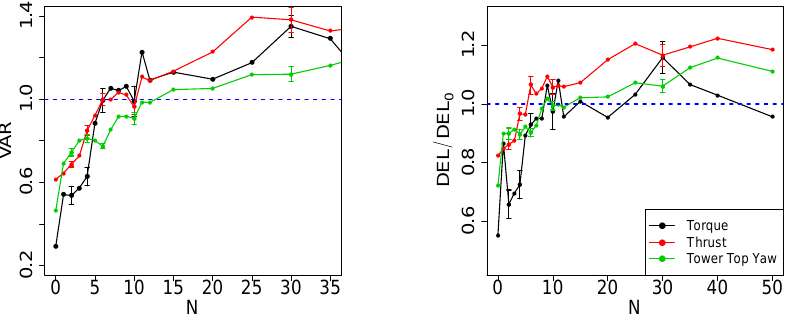
Figure 25. Variance and DELs for different loads versus no. of modes included in the spectral model with added turbulence. Standard errors are shown for the spectral model for N = 2,4,6,10,30. They are estimated from the standard deviations from an ensemble of 10